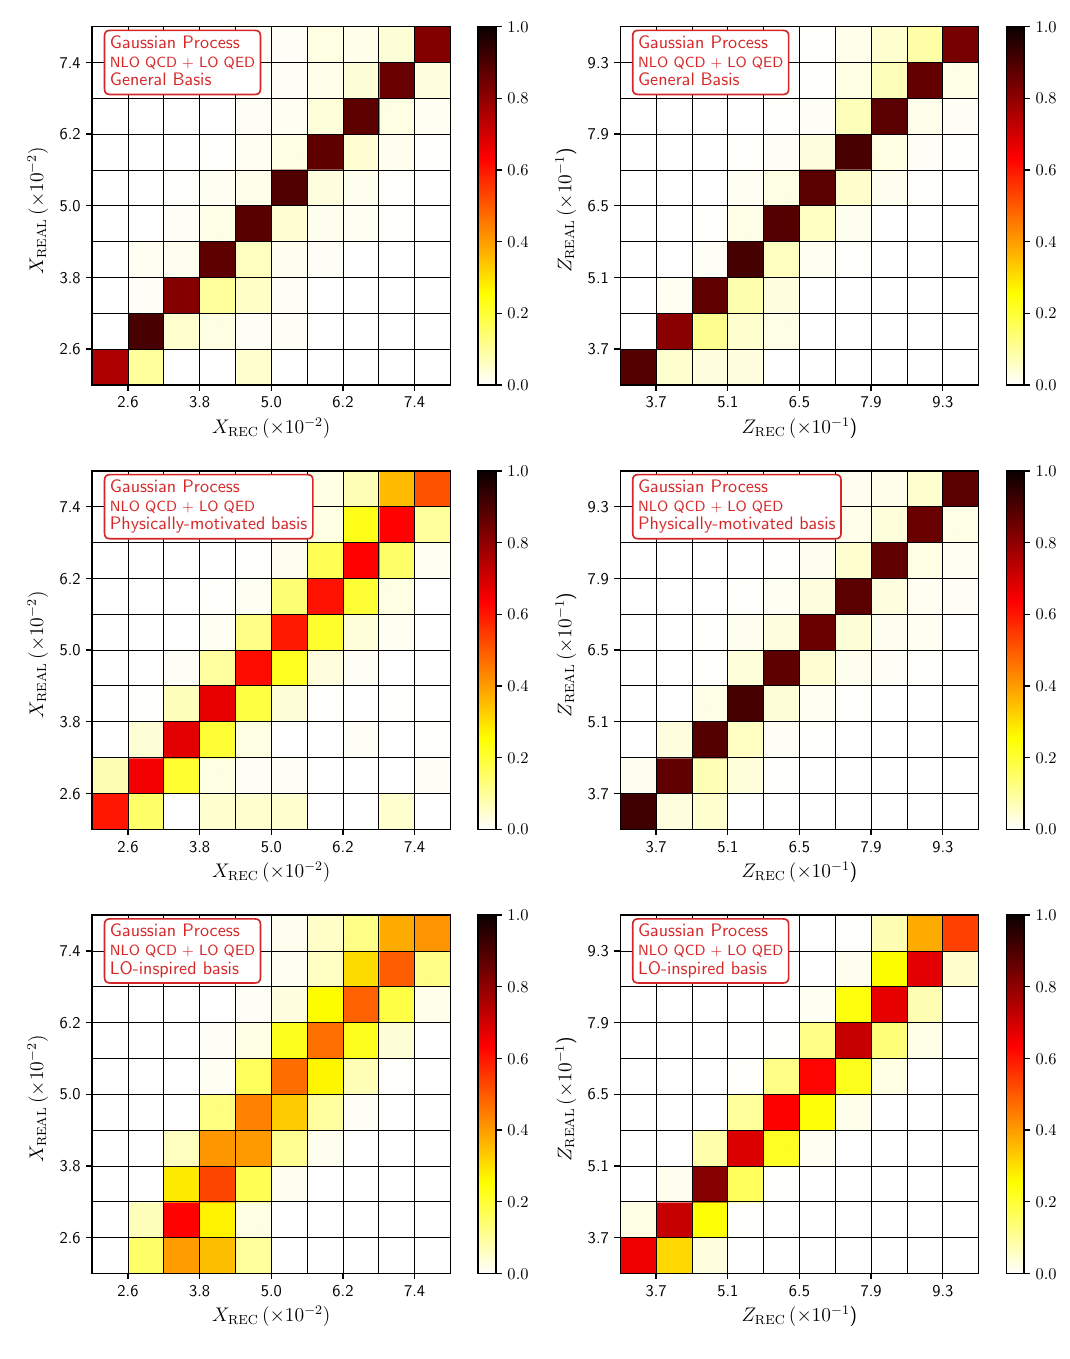
Figure 14: Correlation between the MC momentum fractions (i.e. X versus the ones obtained at NLO QCD + LO QED accuracy ( X the results corresponding to the GR approach, using the general basis (upper row), the physically-motivated basis (middle row) and the LO-inspired basis (lower